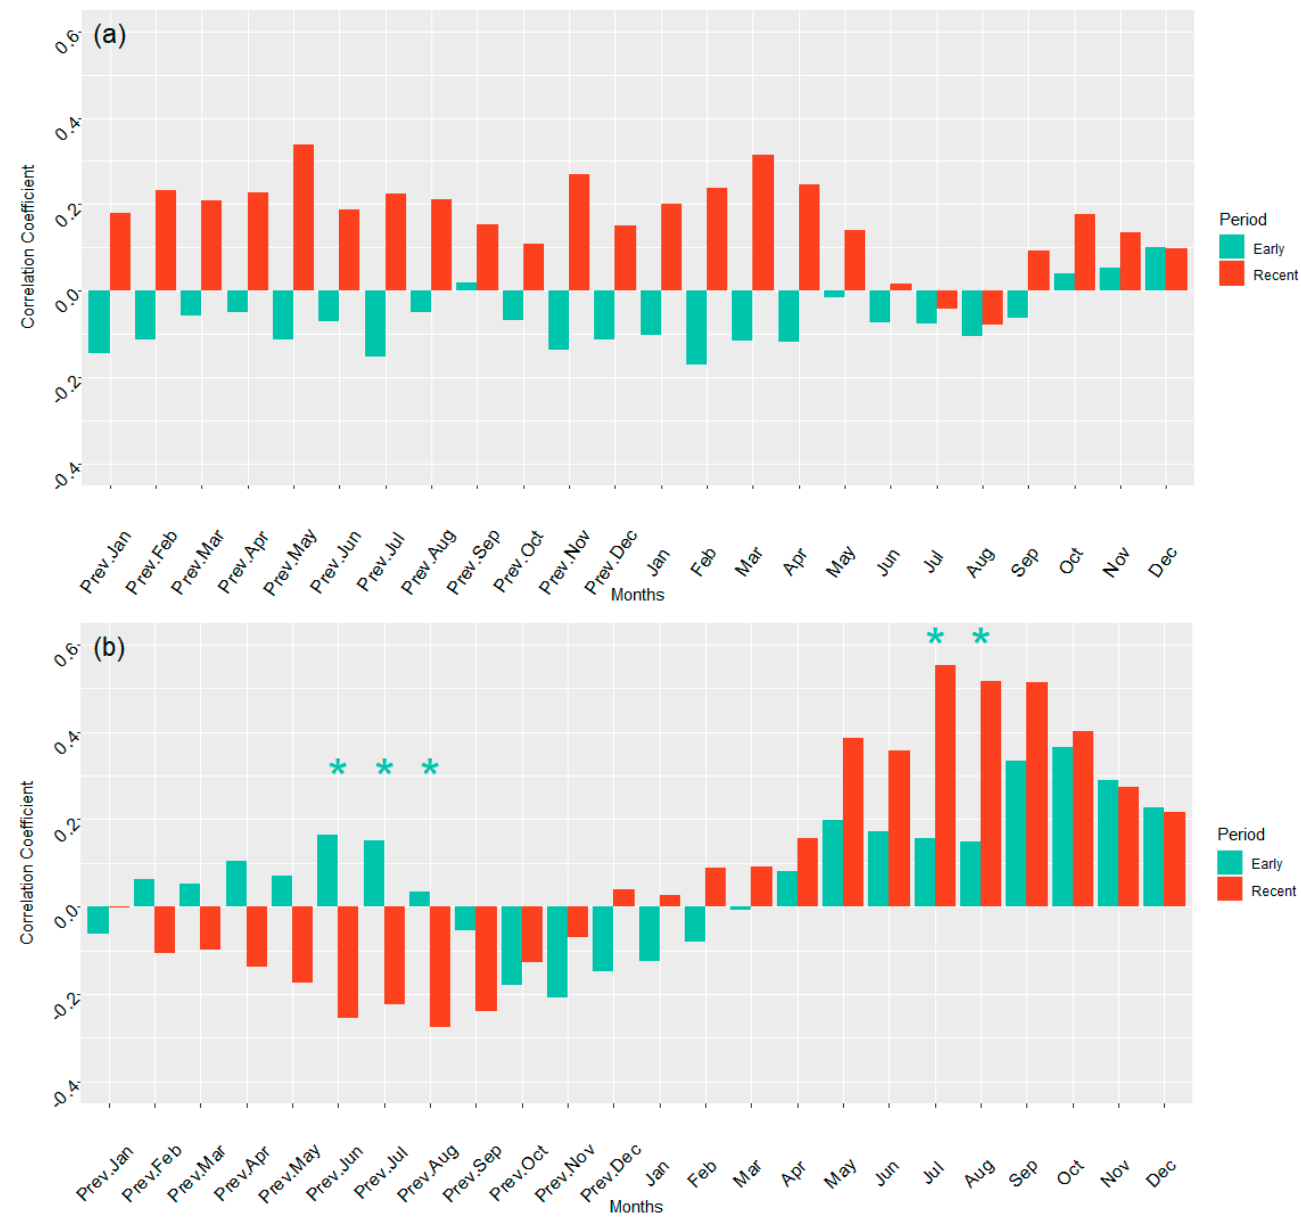
Figure 3. Spearman correlations in each month of 24-month window (12 months in current year and 12 in the previous year) based on standardized tree ring chronology and Palmer Drought Severity Index (PDSI) for ARNWR ( a ) and GDSNWR ( b ) sites. Each site is further divided into time periods including early (pre-1972, teal) and recent (post-1972, red). Significant correlations are denoted by “*”, and colors correspond with periods.